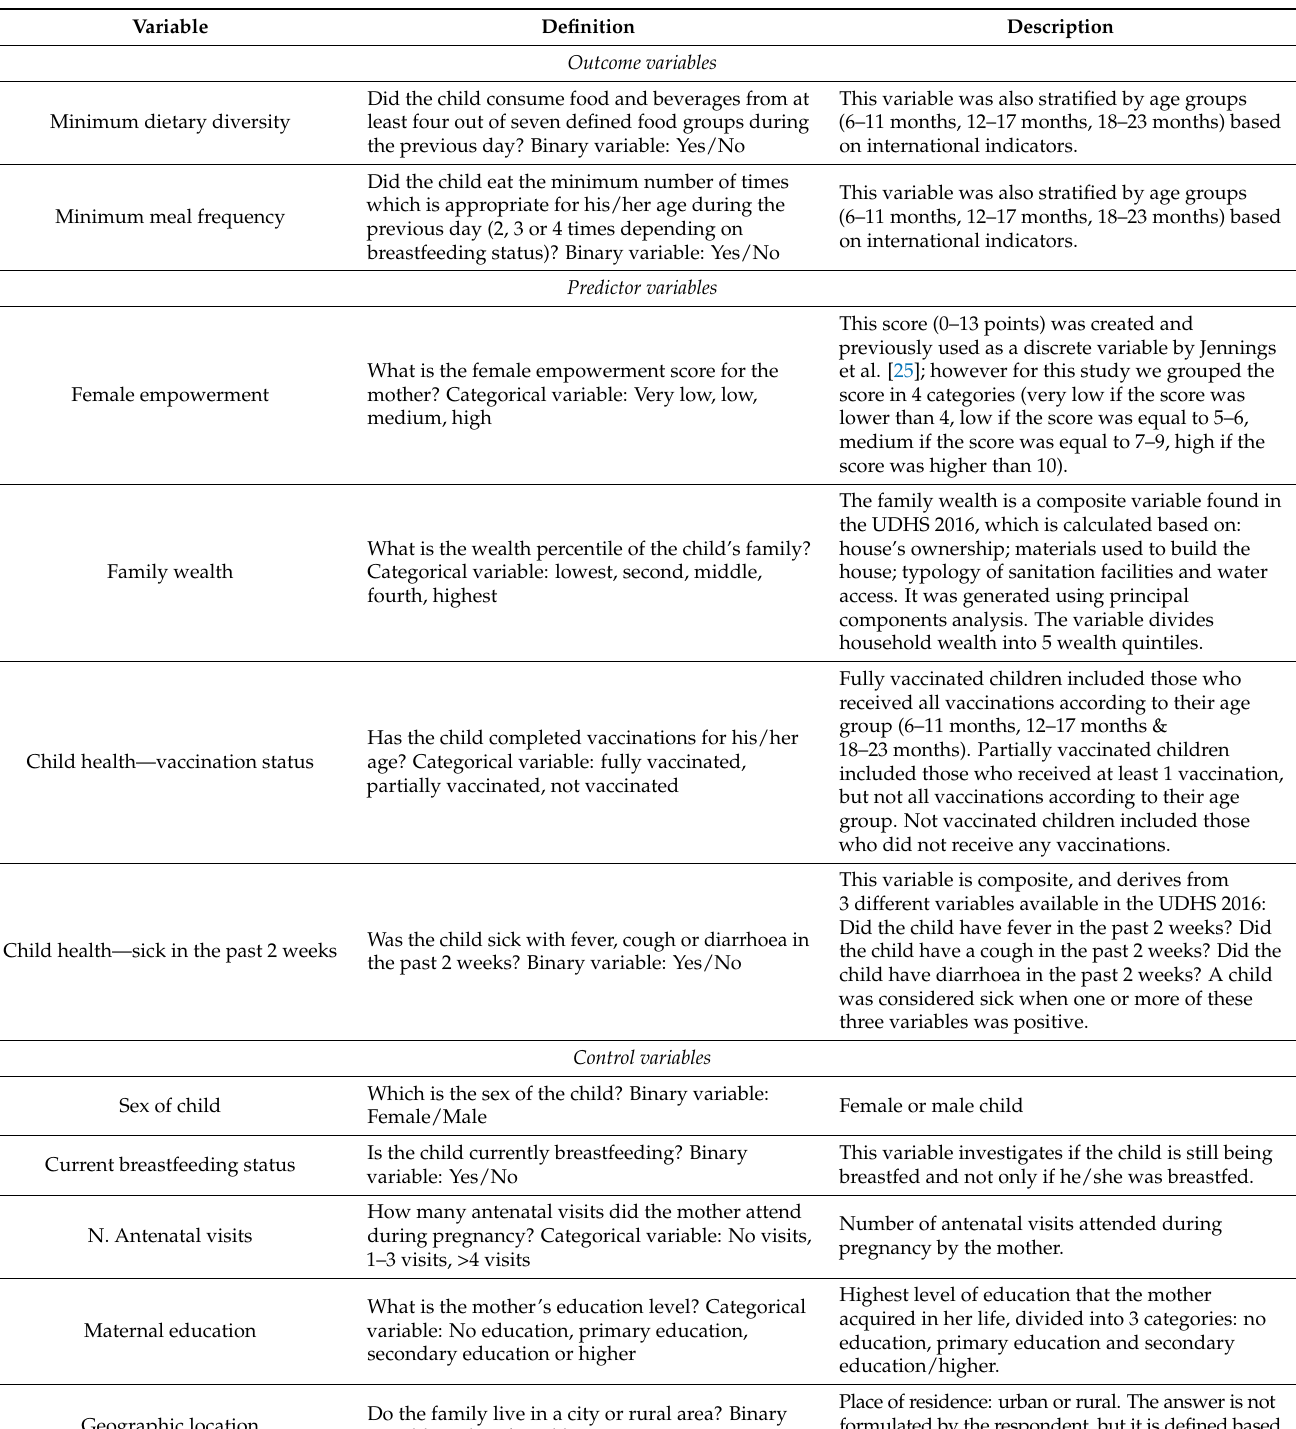
Table 2. Dependent and independent variables, control variables and stratification variables used in this